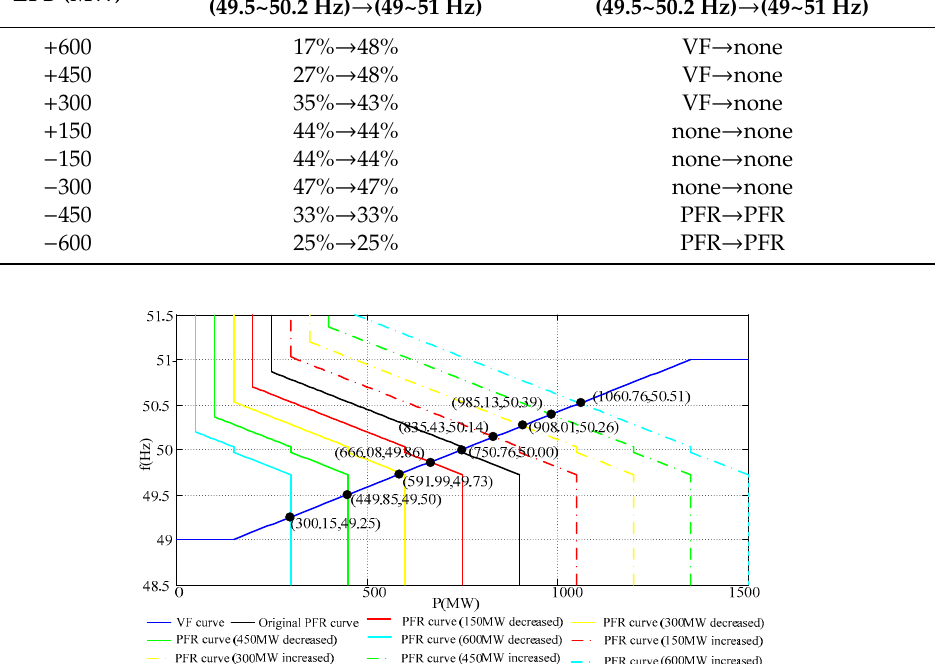
Figure 7. VF curve and PFR curves (control parameters Group 1).